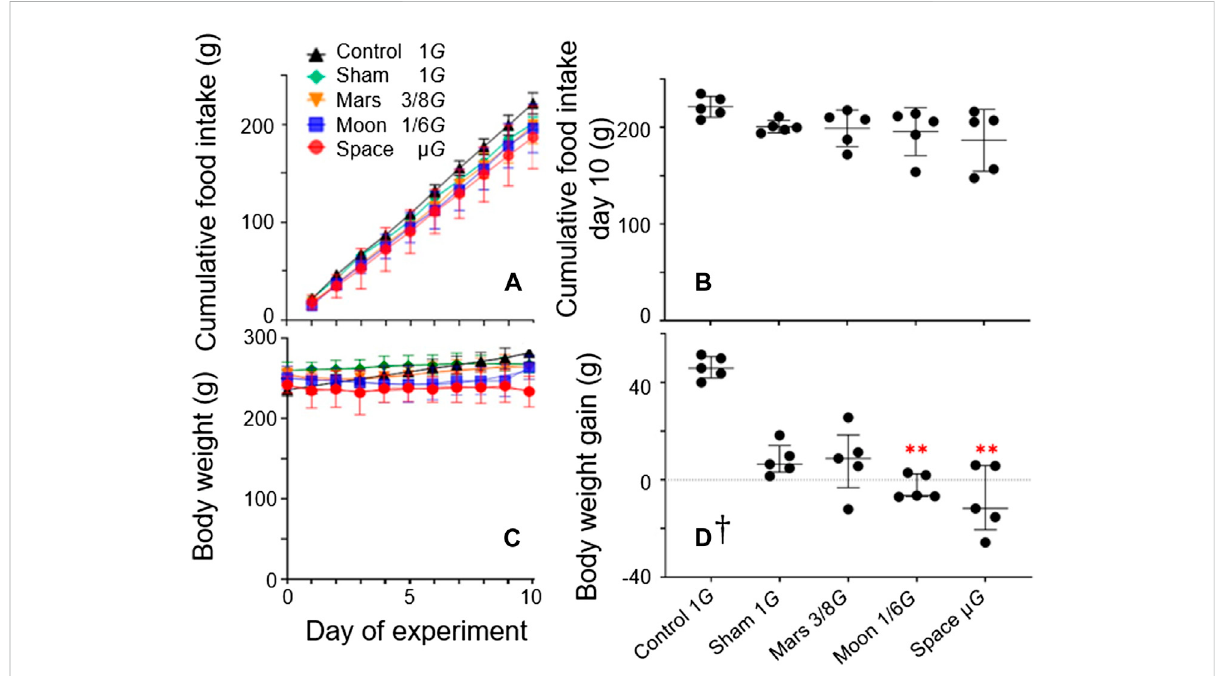
FIGURE 2 Stress exerted by suspension was measured by cumulative food intake during the experiment period (A) and cumulative food intake on day 10 (B) ;dailybodyweightduring theexperiment (C) andoverallweightgainmeasuredattheendoftheexperiment (D) [Symbolsin (C) areidenticalto symbols in (A) . Mean ± SD, one-way analysis of variance; † M (P25, P75), kruskal-wallis test, n = 5. ** p < 0.01 vs. control